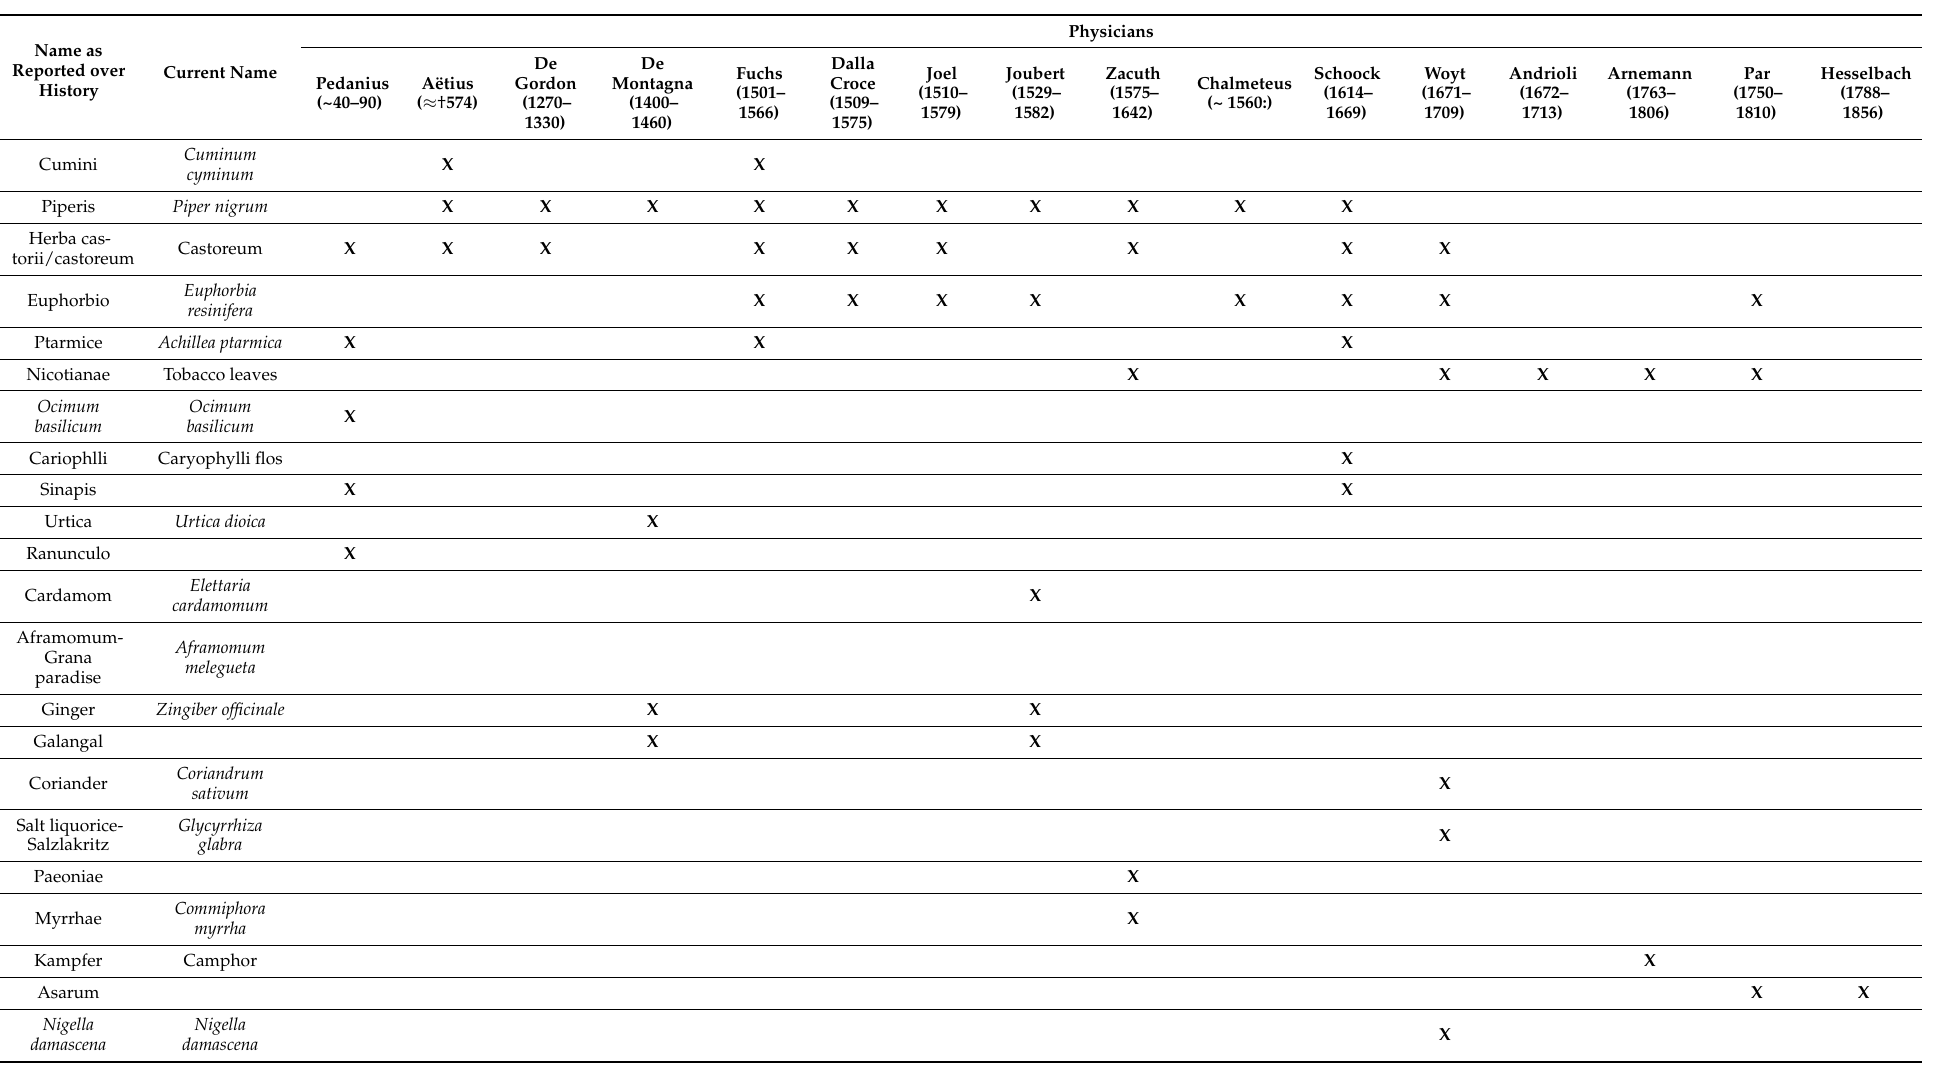
Table 1. Herbs and natural remedies used by various physicians over the centuries to induce